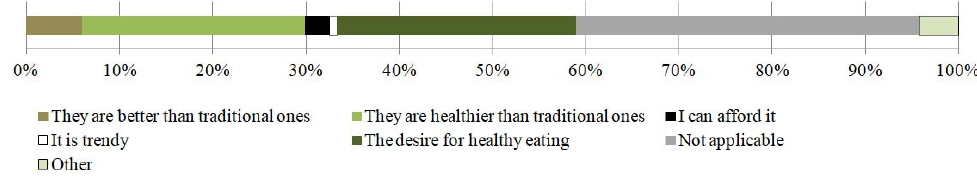
Figure 4. Respondents who bought organic vegetables [%].